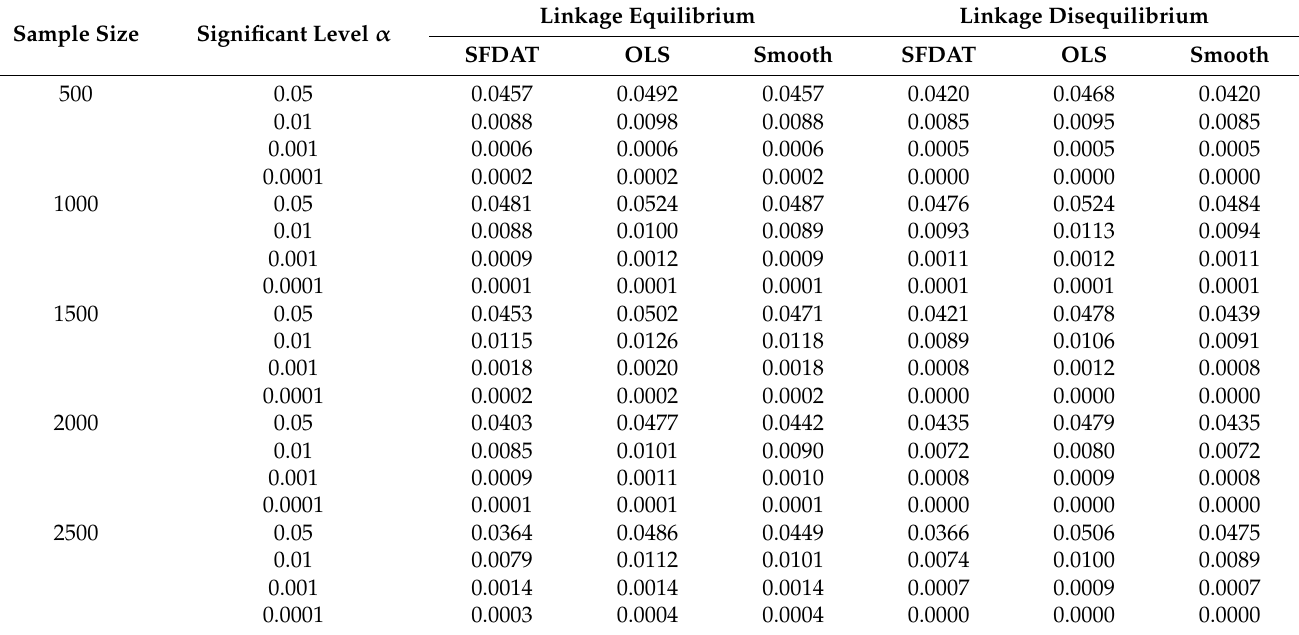
Table 5. Type I error rates of association analysis of simulated quantitative trait of SFDAT, OLS and Smooth based on 1000 simulated replicates for linkage equilibrium and linkage